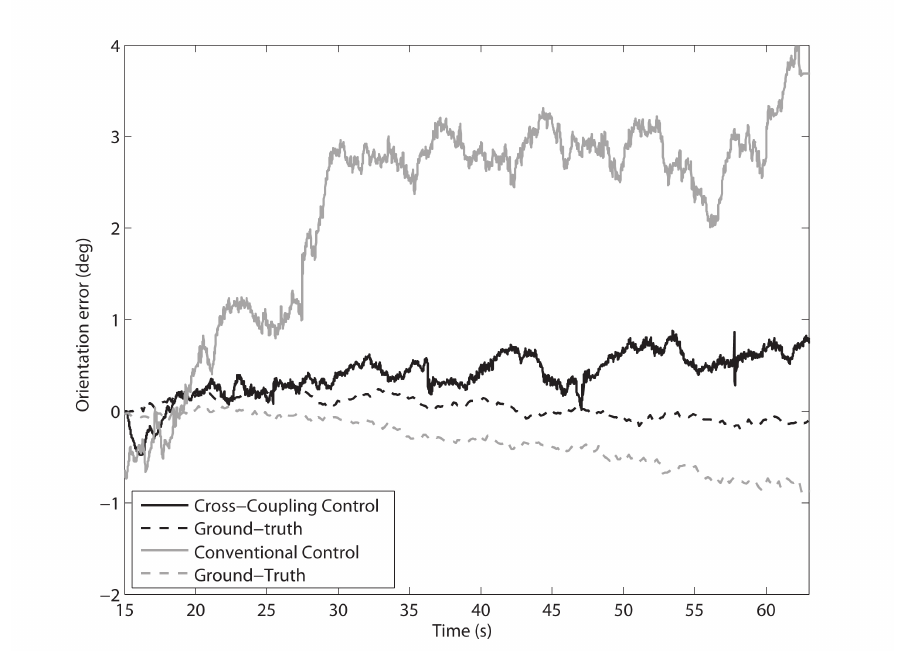
Figure 8. Comparison of cross-coupled control with conventional control: Change in the orientation error during a single 5-meter straight path test on agricultural terrain (V = 10 cm/s). Black solid line: Encoder-derived orientation error using the CCC. Black dashed line: Gyro-derived ground truth. Grey solid line: Encoder-derived orientation error using the CC. Grey dashed line: Gyro-derived ground